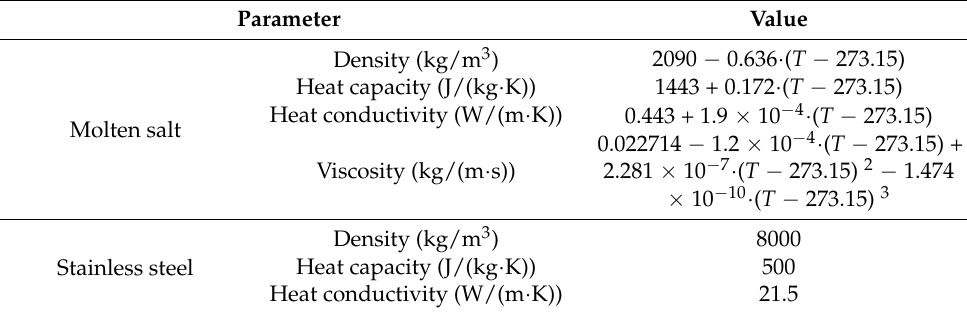
Table 2. Thermal properties of the molten salt and stainless steel.